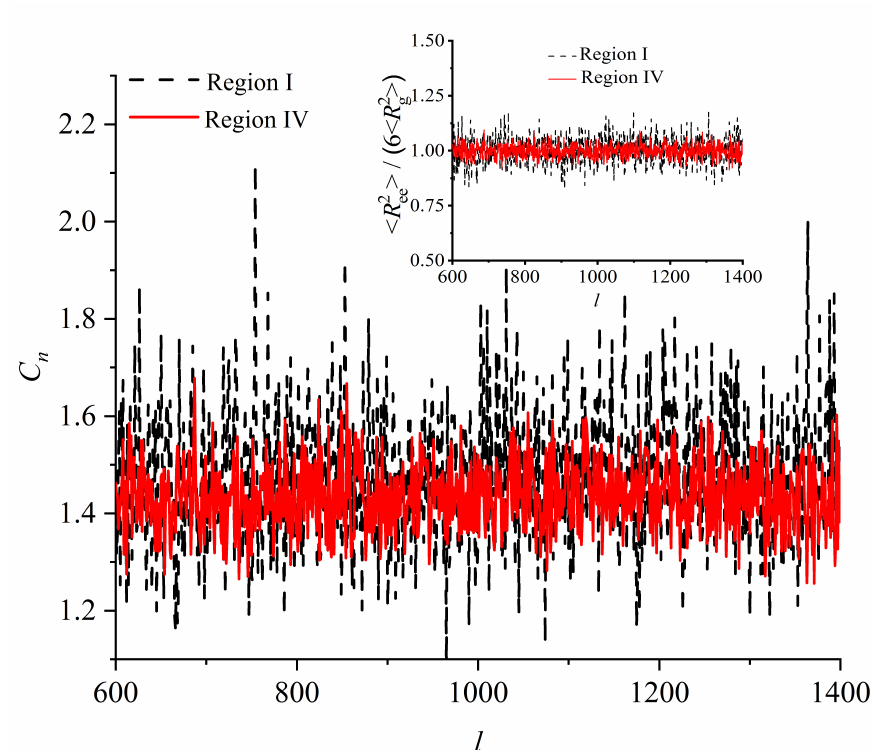
Figure 4. (Main panel) Characteristic ratio, C n , and (inset) ratio of the mean square end-to-end distance divided by six times the mean square radius of gyration, (cid:104) R l , in the disordered solid (Region I) and in the almost perfect FCC crystal (Region